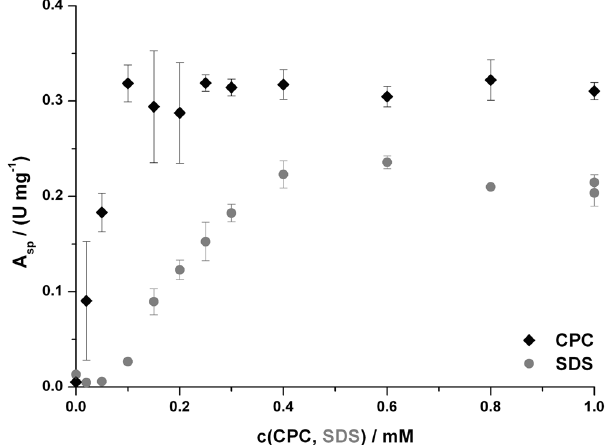
Figure 3. Activation of latent Ab PPO4 by ionic detergents. One data point represents the average of three activity measurements on 1 mM L -tyrosine with the indicated concentration of detergent in the respective assay mixture. The error bars indicate ± one standard